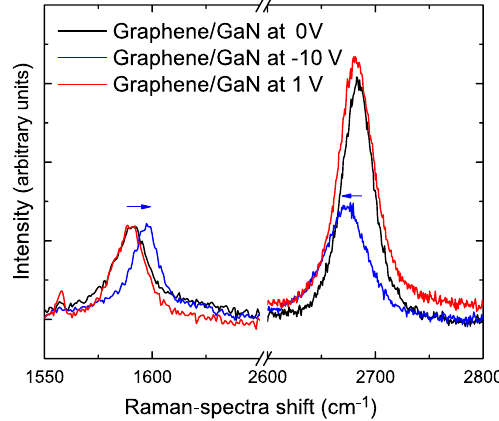
FIG. 3. In-situ Raman spectra taken on graphene/GaN junctions as a function of applied bias: 0 V (black line), þ 1 V (red line), and (cid:4) 10 V (blue line). Blue arrows indicate the direction and magnitude of the shift in the G and 2D peak positions relative to zero bias when the diode is reverse biased.